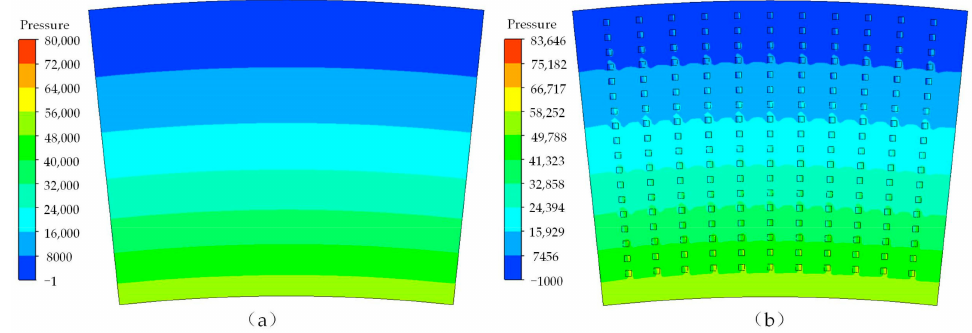
Figure 25. Pressure contour of oil film (( a ) is pressure distribution of oil film with textures; ( b ) is pressure distribution of oil film without textures).